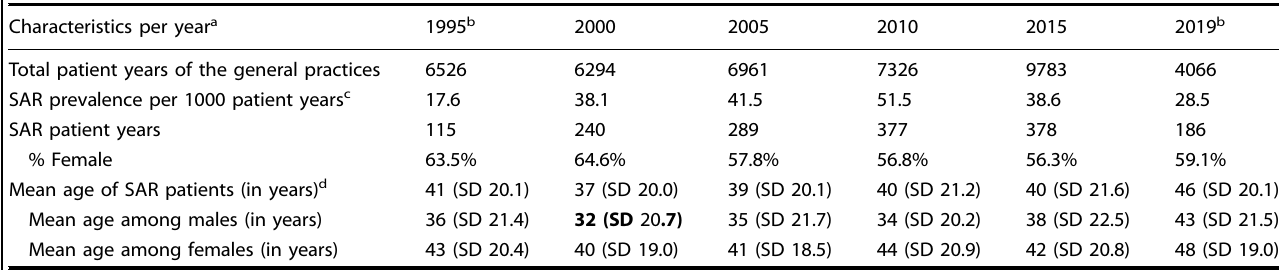
Table 1. Characteristics of SAR patients and the total patient population within the general practices of some of the years. Characteristics per year a